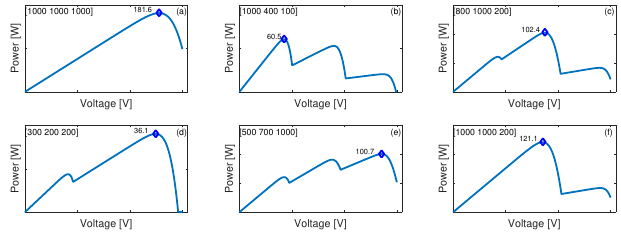
Figure 3. P-V curve shapes for an array of three series-connected panels under PSC. The vector [ G upper left corner, represents the irradiance distribution in the panels for that case and the diamond-shaped mark spot the